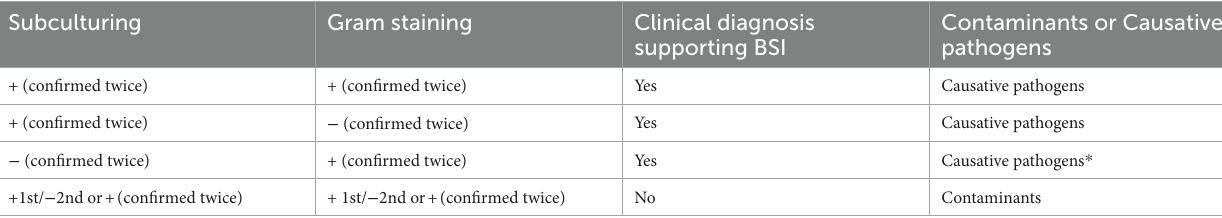
TABLE 1 Criteria used to assess contaminants or causative